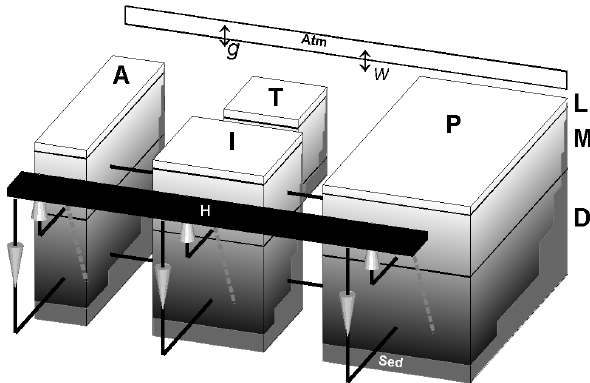
Fig. 1. Schematic representation of the LOSCAR model (Pale- ocene/Eocene configuration). A = Atlantic, I = Indian, P = Pacific, T = Tethys ocean, H = High-latitude surface, L = Low-latitude sur- face, M = interMediate, D = Deep box. Weathering fluxes and gas exchange with the atmosphere (Atm) are indicated by “w” and “g”, respectively. Steps on the faces of ocean boxes indicate sediments